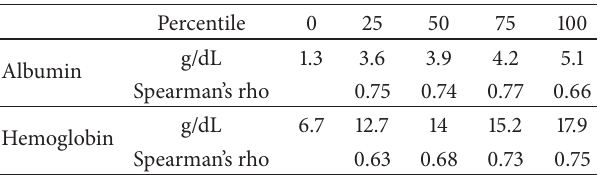
Table 2: Correlation between HbA1c and fructosamine by albumin and hemoglobin